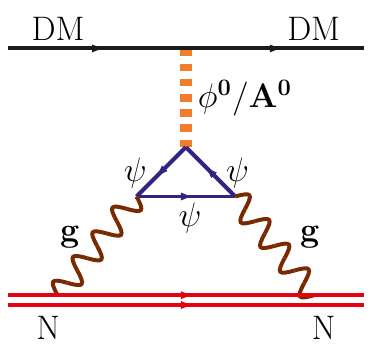
Figure 9. DM-Nucleon scattering diagram induced by the portal-VLQ loop